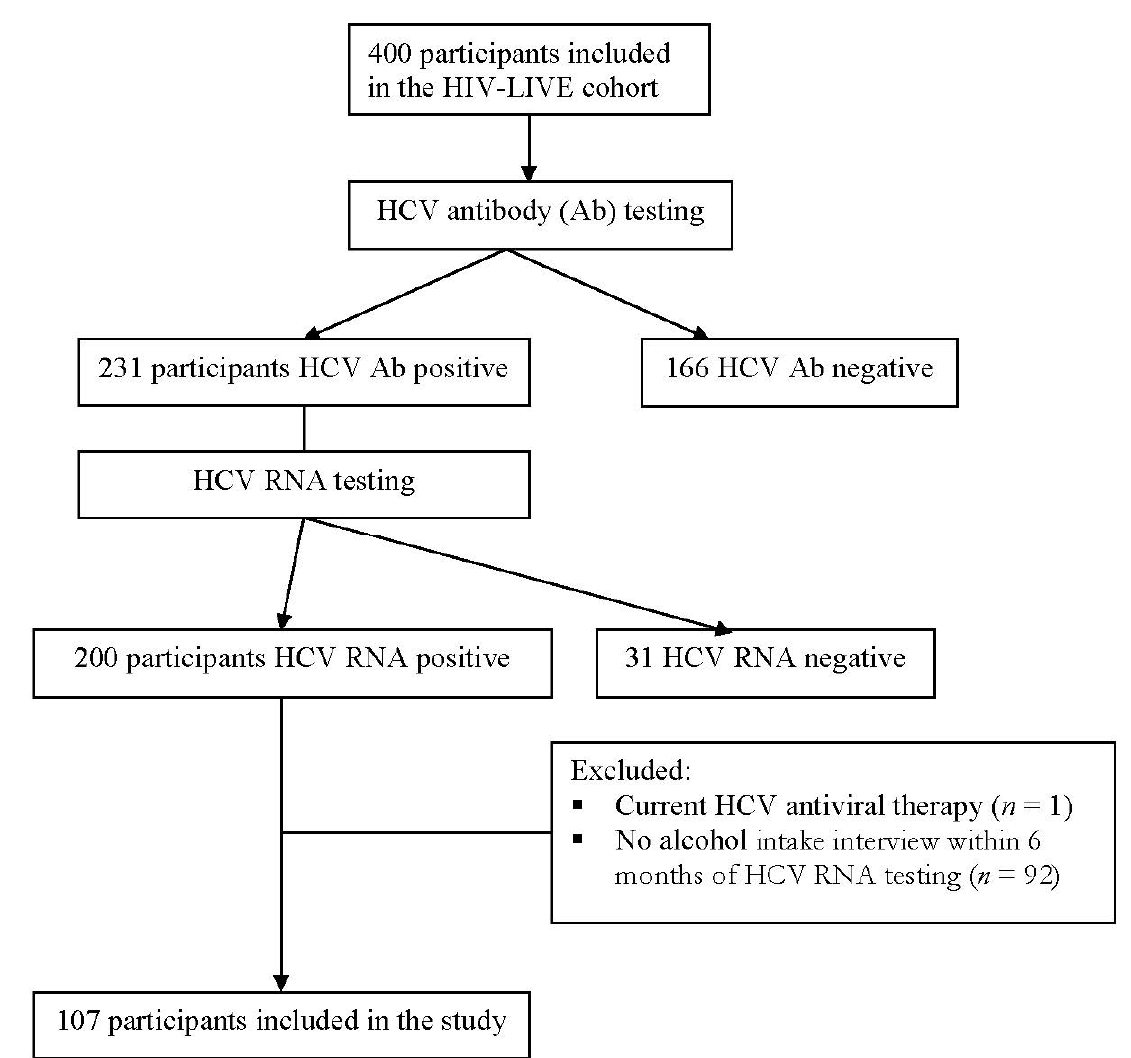
Figure 1. Flow diagram of enrollment into the study.